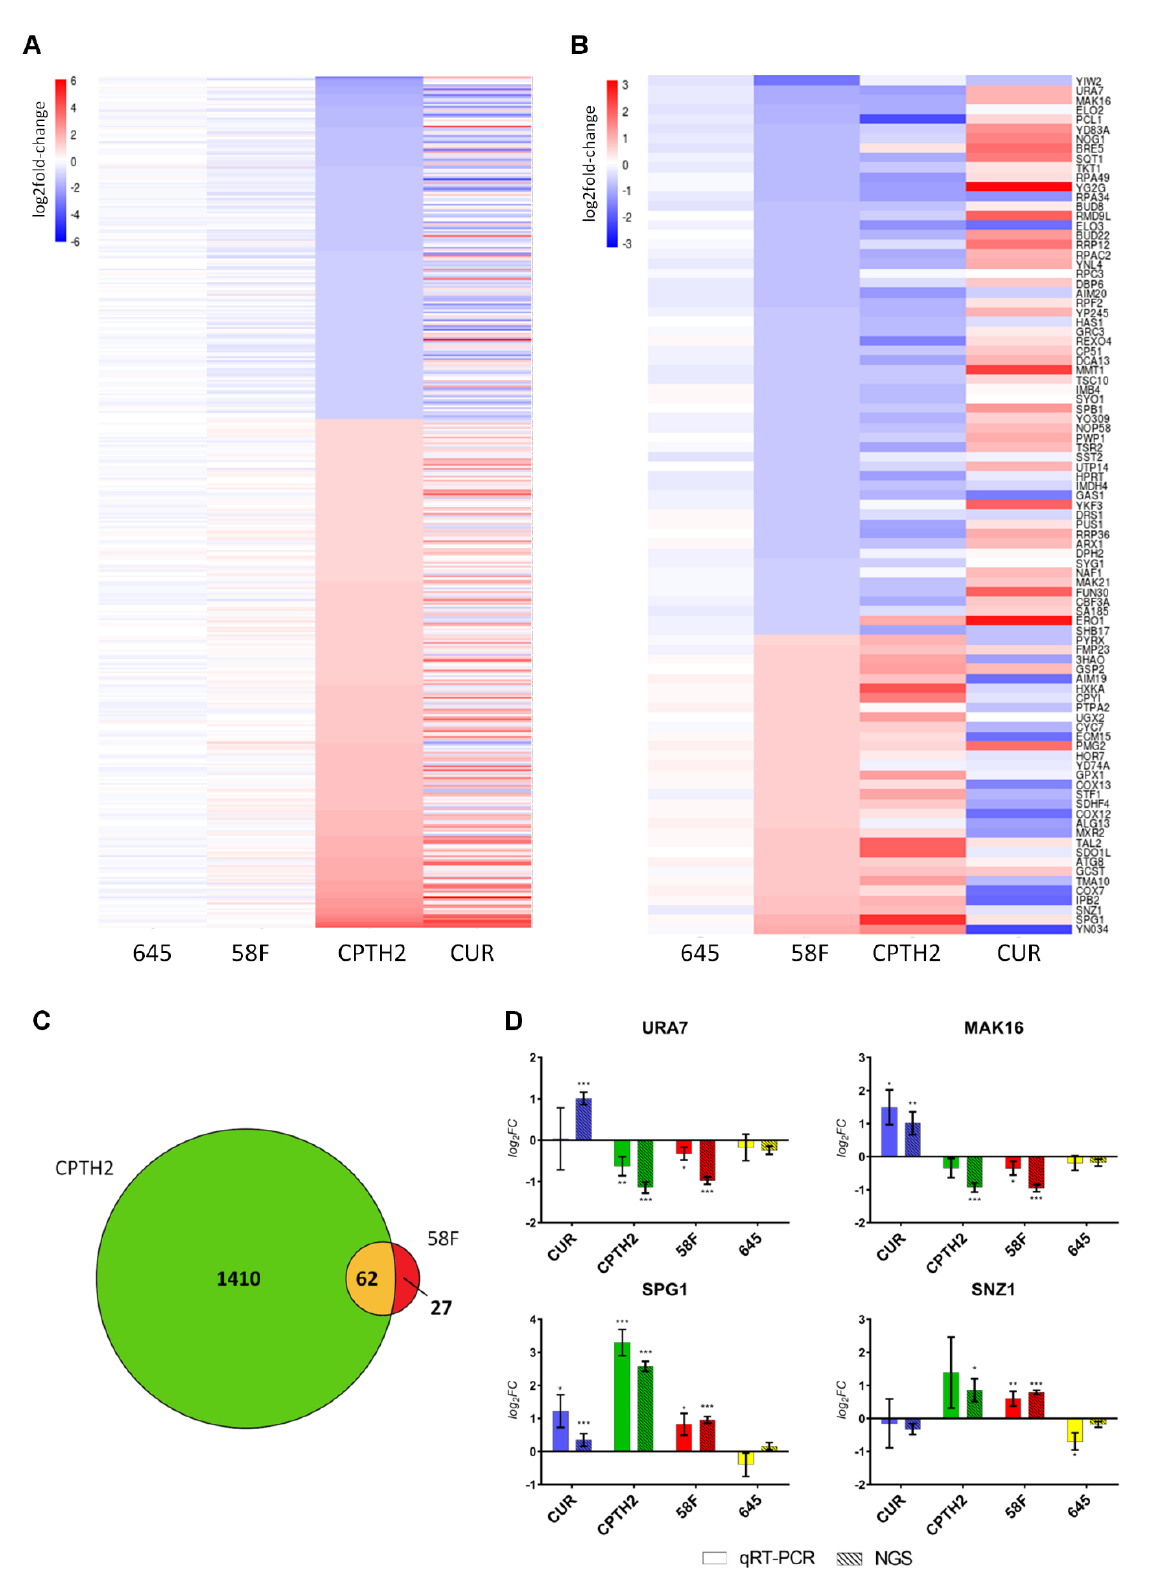
Figure 2. The expression of scFv-58F intrabody modulates a small but largely overlapping subset of genes altered by HATis. ( A ) Heatmap of mRNAs ( n = 435) that are significantly modulated after CPTH2 treatment. mRNAs are sorted by log2FC in CPTH2 vs. DMSO: expression patterns in the